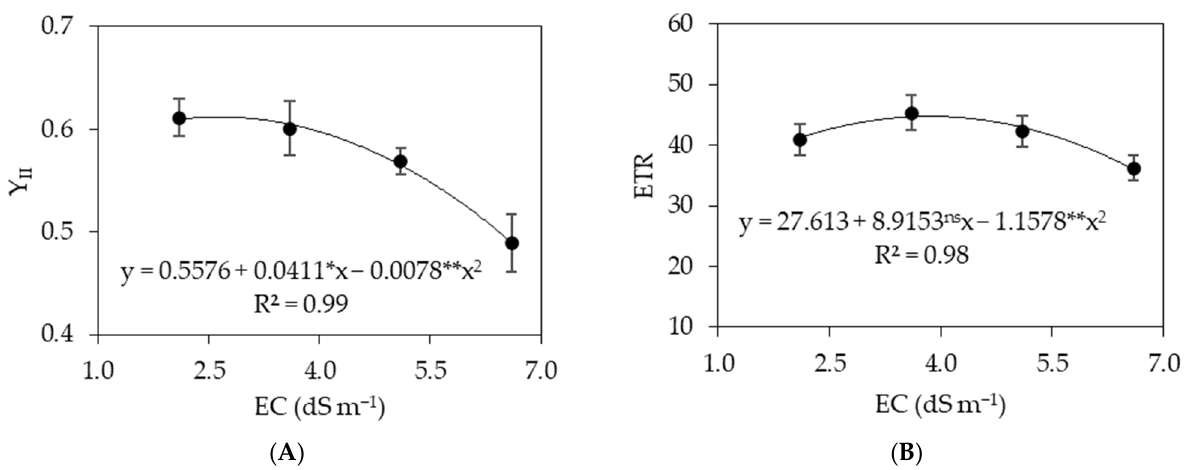
Figure 6. Quantum efficiency of photosystem II—Y II ( A ) and electron transport rate—ETR ( B ) of ‘Canindé’ okra cultivated in a hydroponic system as a function of the electrical conductivity of the nutrient solution 60 days after transplanting. * and ** significant at p ≤ 0.05 and ≤ 0.01, respectively. The vertical lines represent mean +/ − .standard error (n = 4).